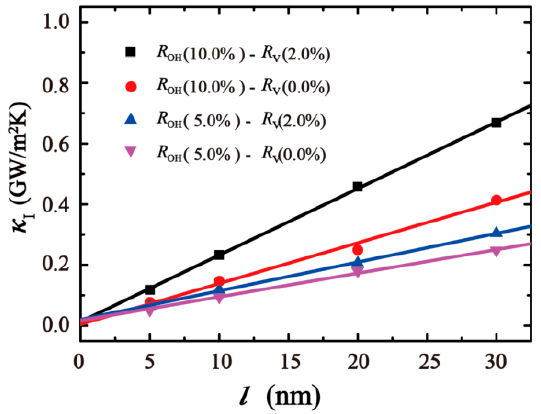
Figure 8. The interfacial thermal conductance κ I of four types as a function of the overlap length (5 nm, 10 nm, 20 nm, 30 nm).